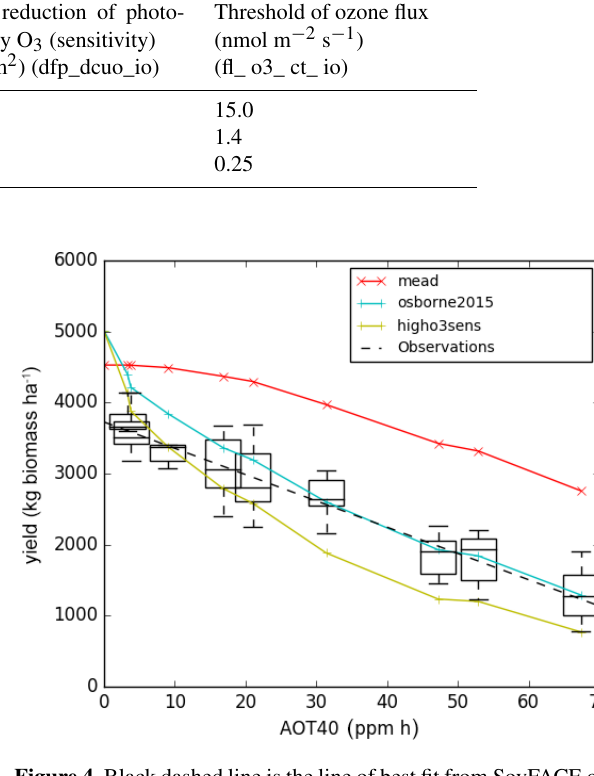
Figure 3. Aboveground carbon biomass of soybean at harvest stage for calibrated Joint UK Land Environment Simulator with Crop module turned on (JULES-crop) using the Mead soybean tun- ing (red), Osborne et al. (2015) standard parameters with Sitch et al. (2007) low ozone sensitivity (blue), high ozone sensitiv- ity (green), and observation from SoyFACE from Betzelberger et al. (2012).